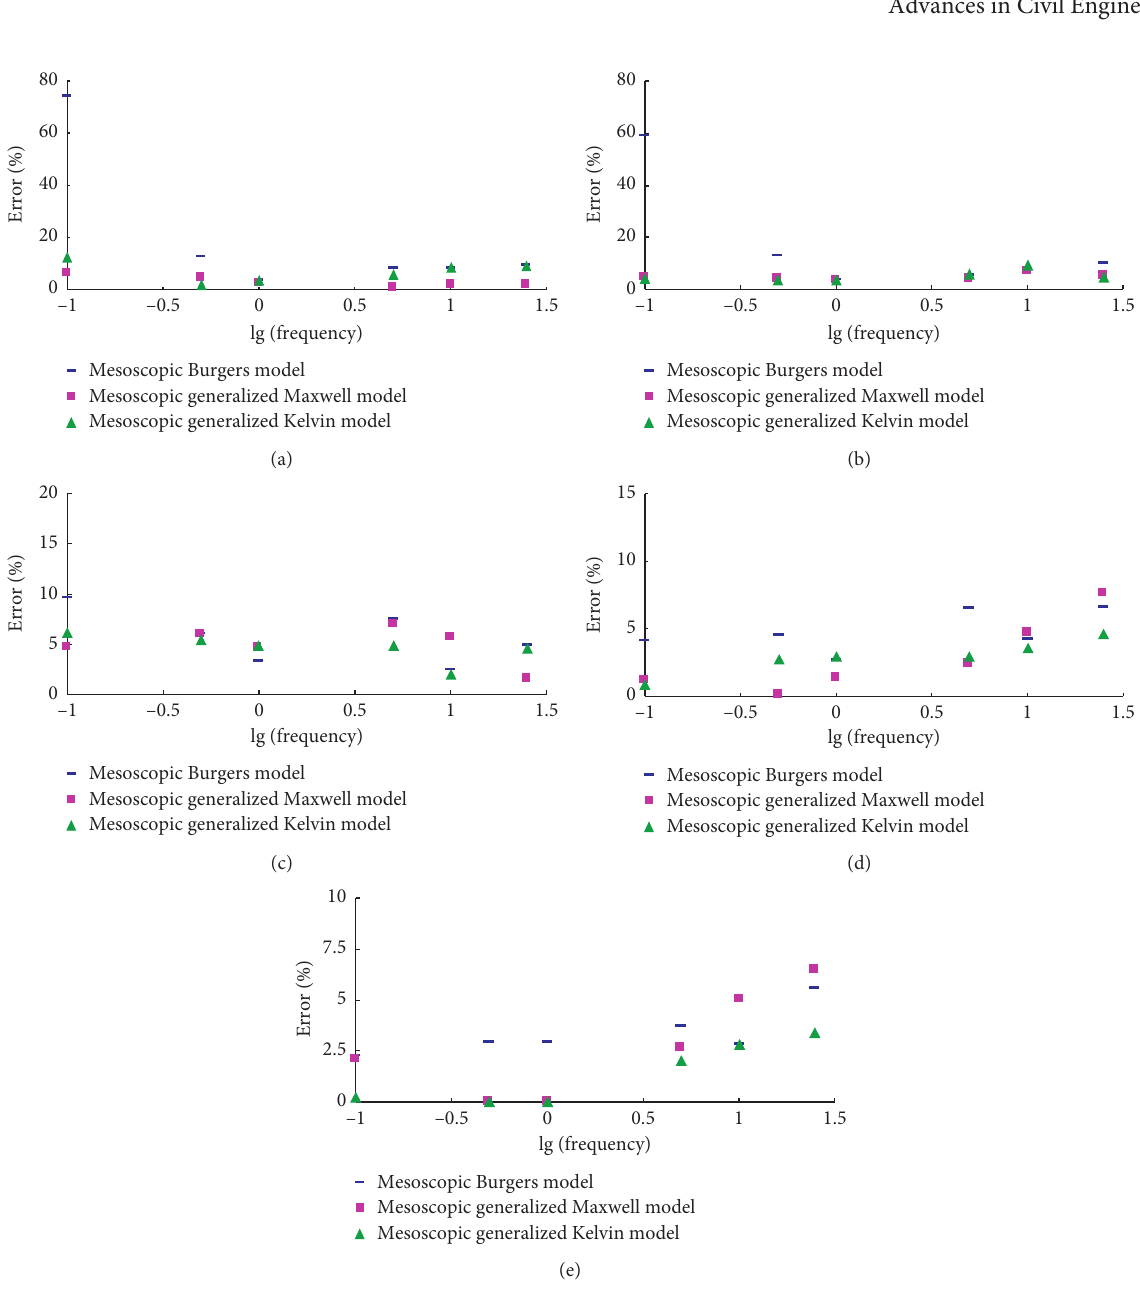
Figure 13: Errors of phase angle. (a) − 6 ° C. (b) 4 ° C. (c) 16 ° C. (d) 27 ° C. (e) 38 °